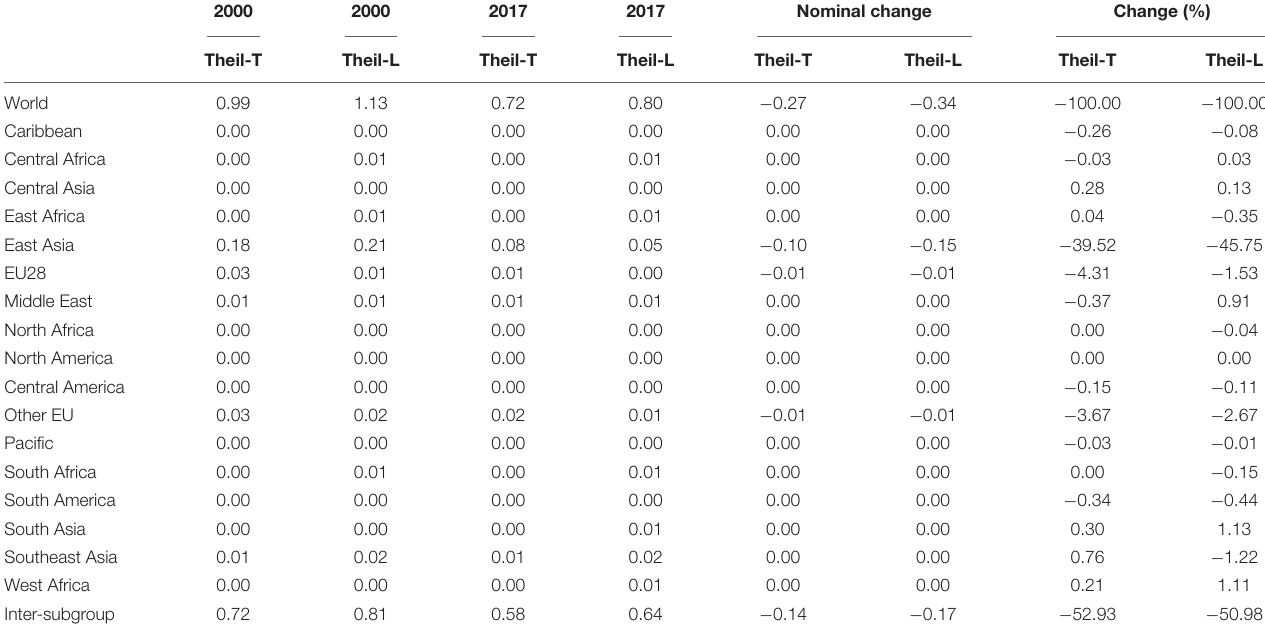
TABLE 7 | Decomposition of change in inequality for 17 regional subgroups, 2000–2017.